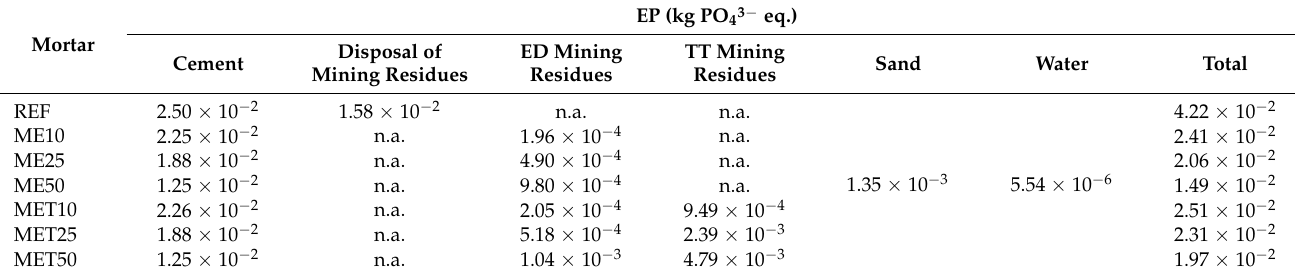
Table A6. Environmental impacts in the Eutrophication Potential category, from the production of 1 t of mortars with cement and treated mining residues as binder